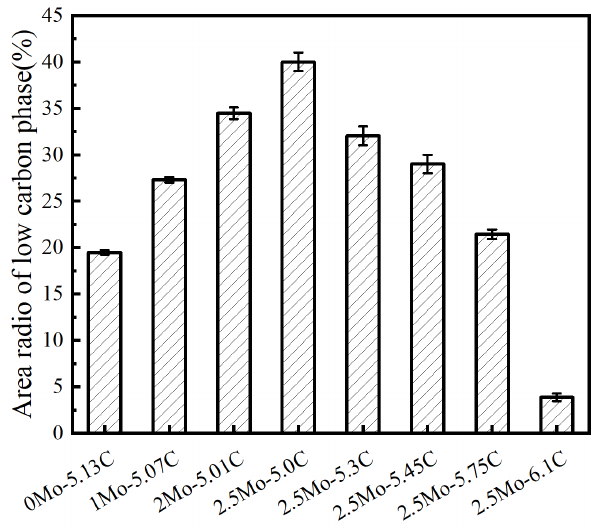
Figure 4. Area fraction of eta phase of WC-13Co with different additions of Mo and C.